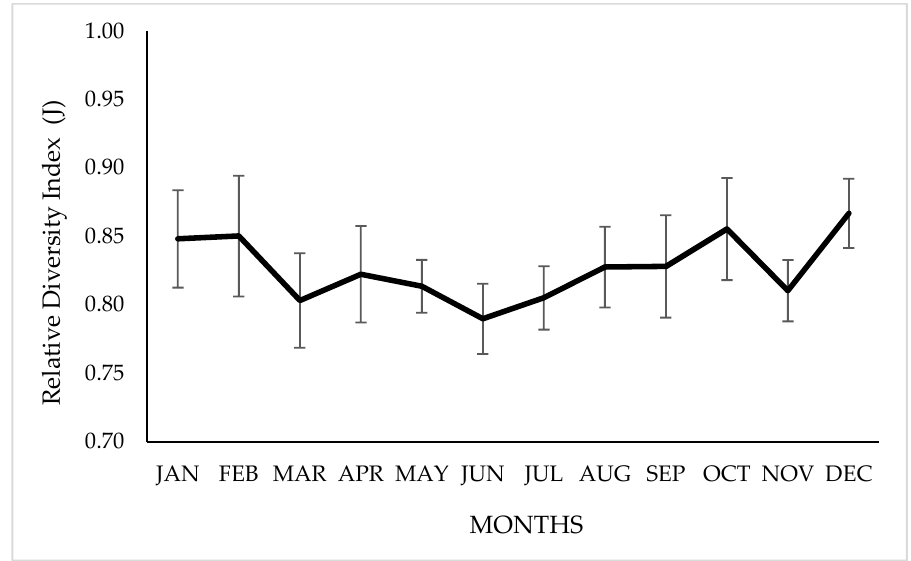
Figure 4. Monthly variation in the relative diversity index (J) of the vicuña diet, grazing on natural grasslands of Chilean highlands. Bars indicate a standard deviation above or below the means.